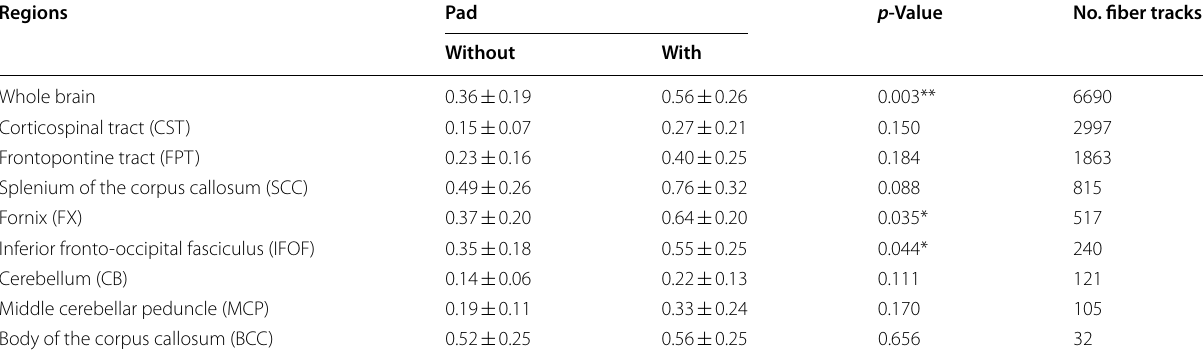
Table 1 Brain areas showing significantly increased quantitative anisotropy (QA) values with high‑dielectric pad compared to